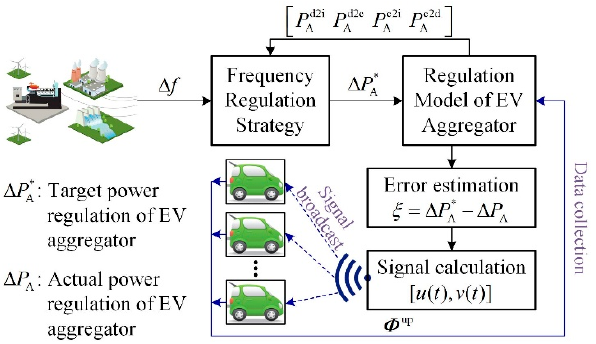
Figure 5. Frequency regulation process with the EV aggregator.